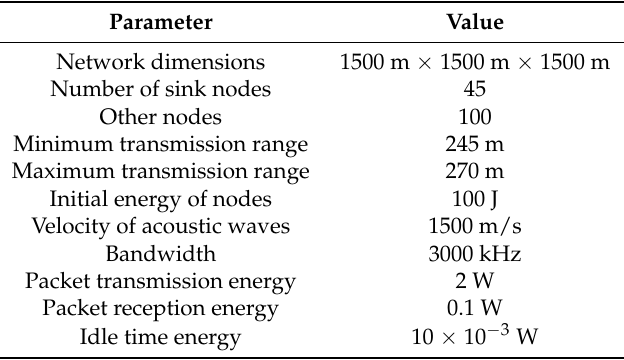
Table 3. Network parameters